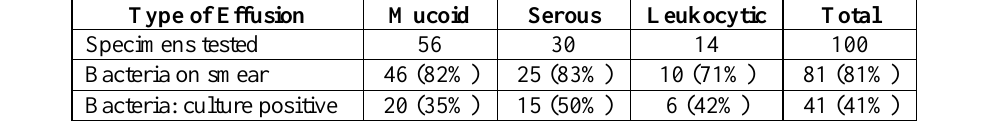
Bacterial Isolates From Middle Ear